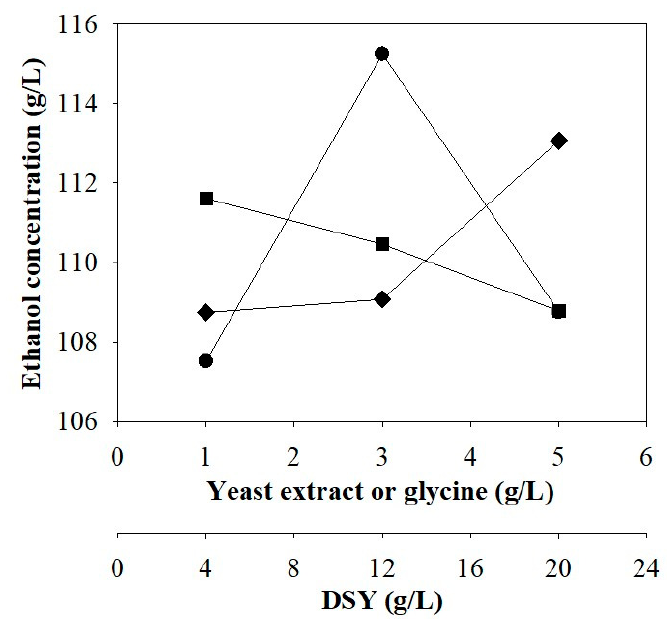
Energies 2019 , 12 , x FOR PEER REVIEW Figure 1. Ethanol fermentation profiles of Run 1 from the sweet sorghum juice supplemented with Figure 2. Ethanol concentrations at various levels and factors in the orthogonal array design (OAD) yeast extract (1 g/L), DSY (4 g/L), and glycine (1 g/L) by S. cerevisiae NP01 (  = log viable cells,  = Figure 2. Ethanol concentrations at various levels and factors in the orthogonal array design (OAD) test (  = yeast extract,  = DSY,  = glycine, DSY = dried spent yeast). Figure 2. Ethanol concentrations at various levels and factors in the orthogonal array design (OAD) = glycine, DSY = dried spent yeast). pH,  test ( (cid:8) = yeast extract, (cid:4) = DSY, test (  = yeast extract,  = DSY,  = glycine, DSY = dried spent yeast).